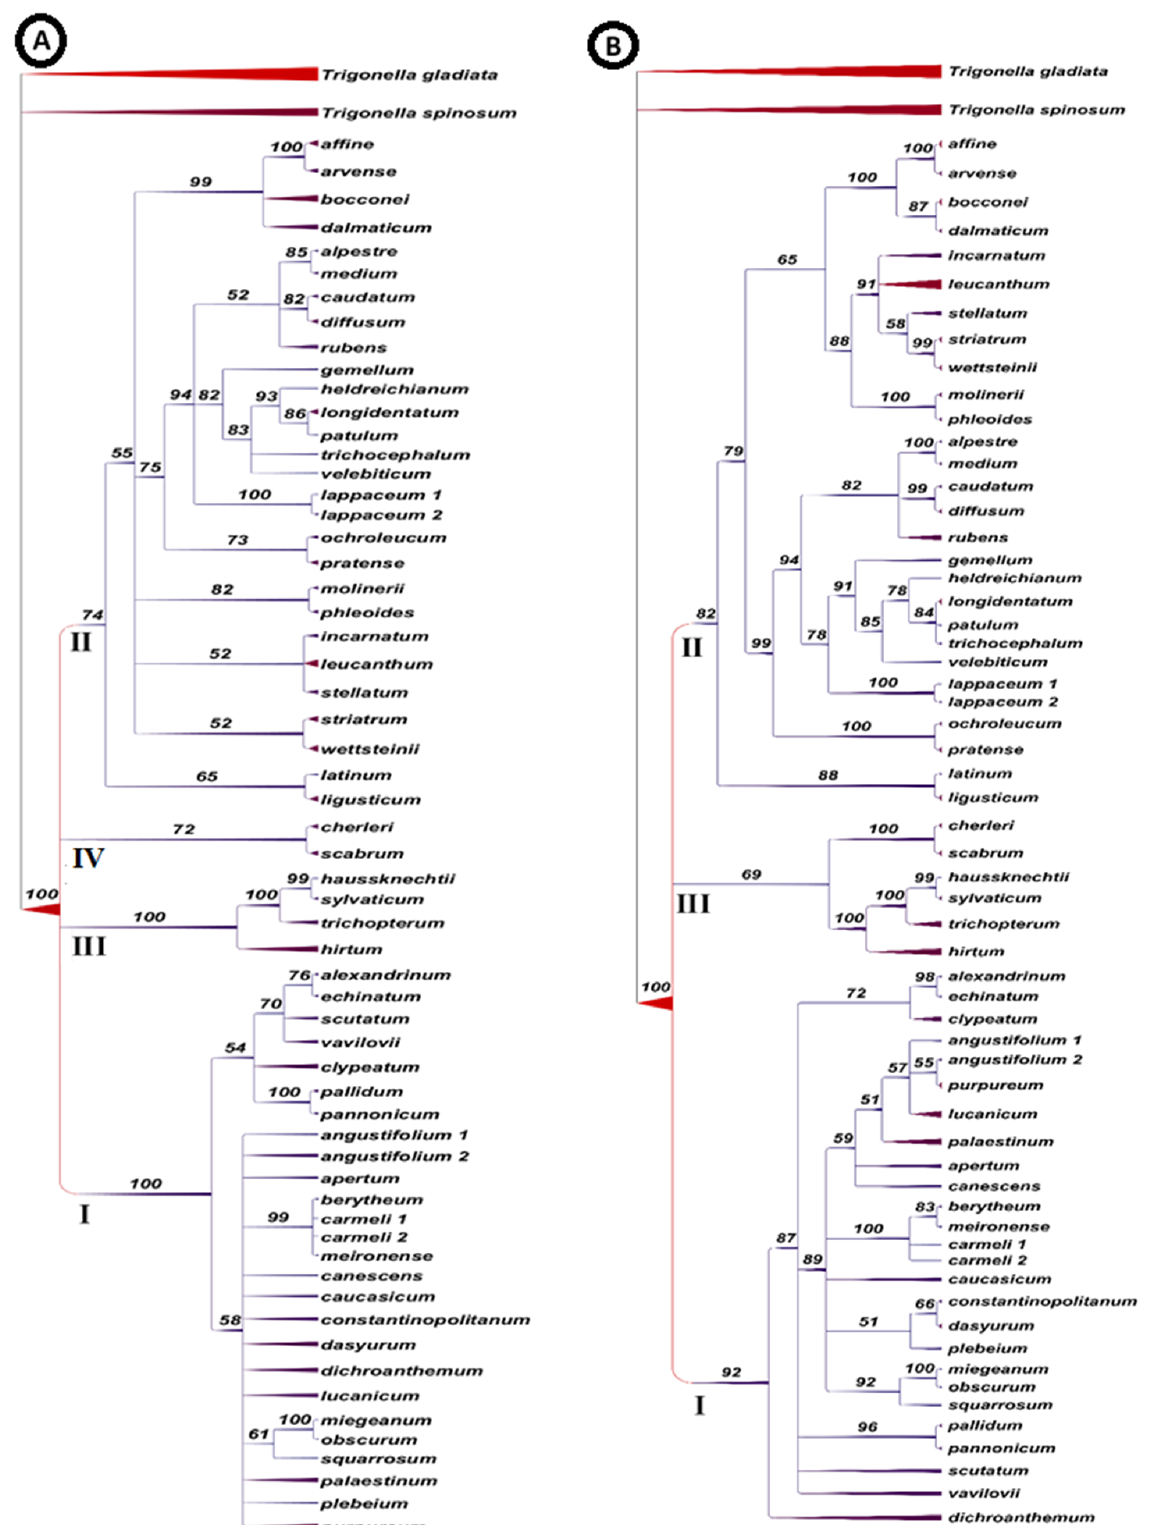
Figure 2. Two phylogenetic trees of the species in the section Trifolium constructed using MrBayes using TreeGraph 2, for visualizing phylogenetic trees. ( A ) tree based on ITS sequence and inormative indels and ( B ) tree based on combined ITS sequence plus indels and morphlogical